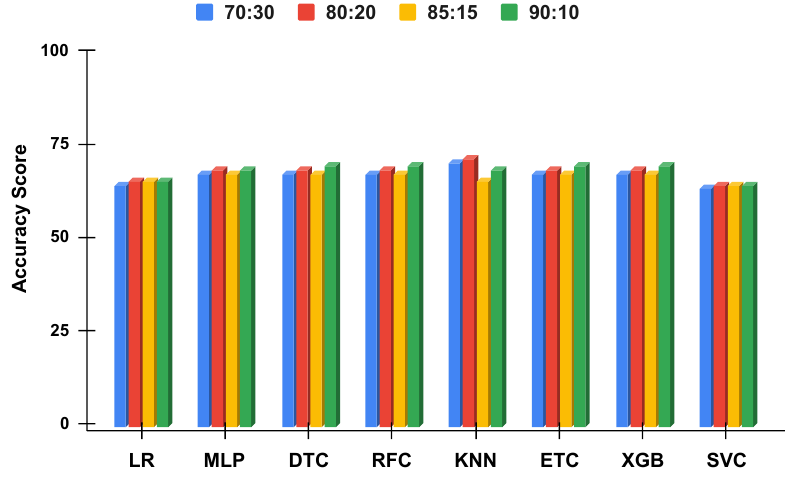
Figure 11. The applied techniques performance comparative analysis of different data split ratios with proposed technique using imbalanced